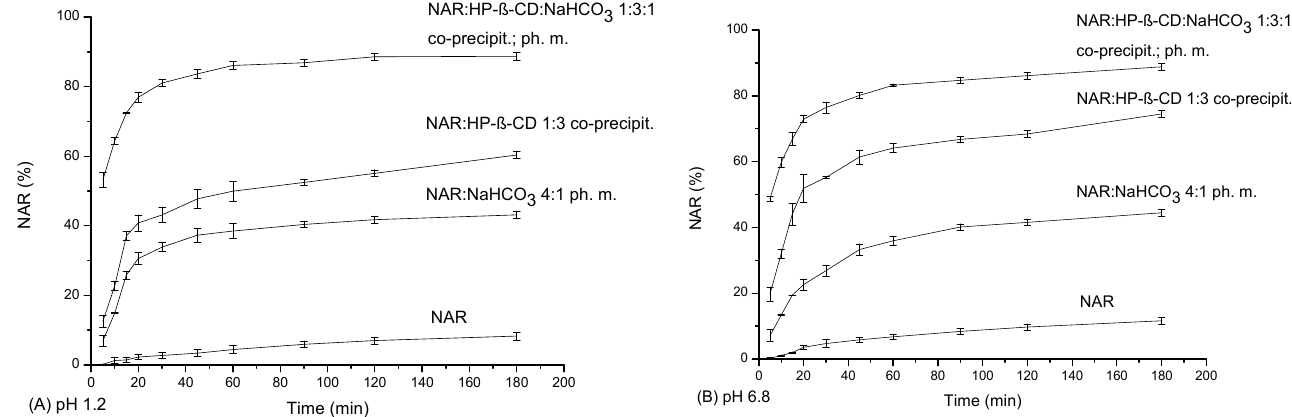
Figure 4. Apparent solubility of NAR, the binary system (NAR:HP- β -CD) obtained by the co-pre-